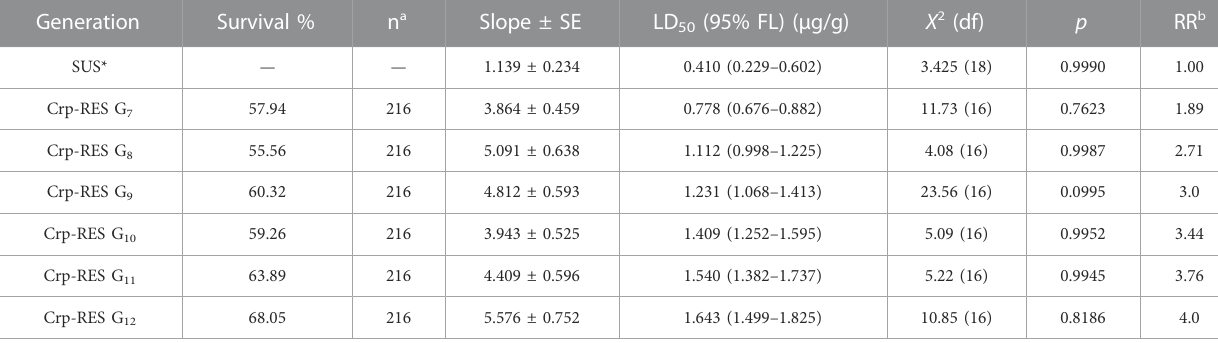
TABLE 1 Dose – mortality response (µg/larva) for the chlorantraniliprole-susceptible strain. Generation